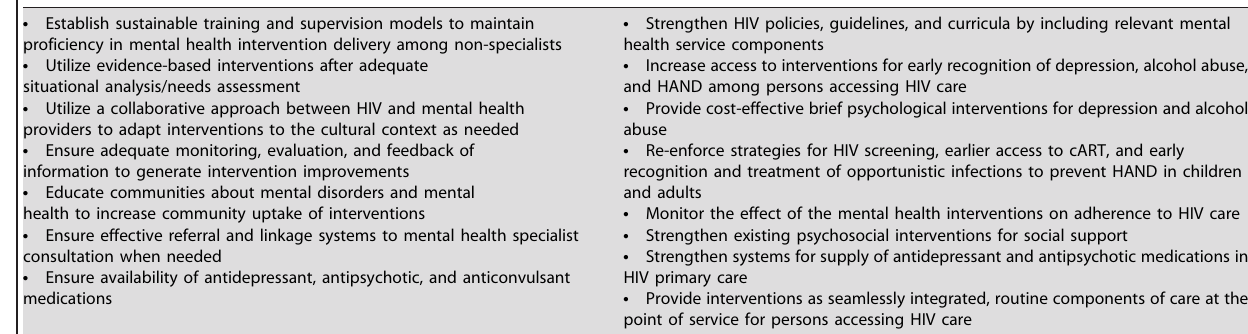
Table 3. Recommendations for Delivering Mental Health Services in HIV